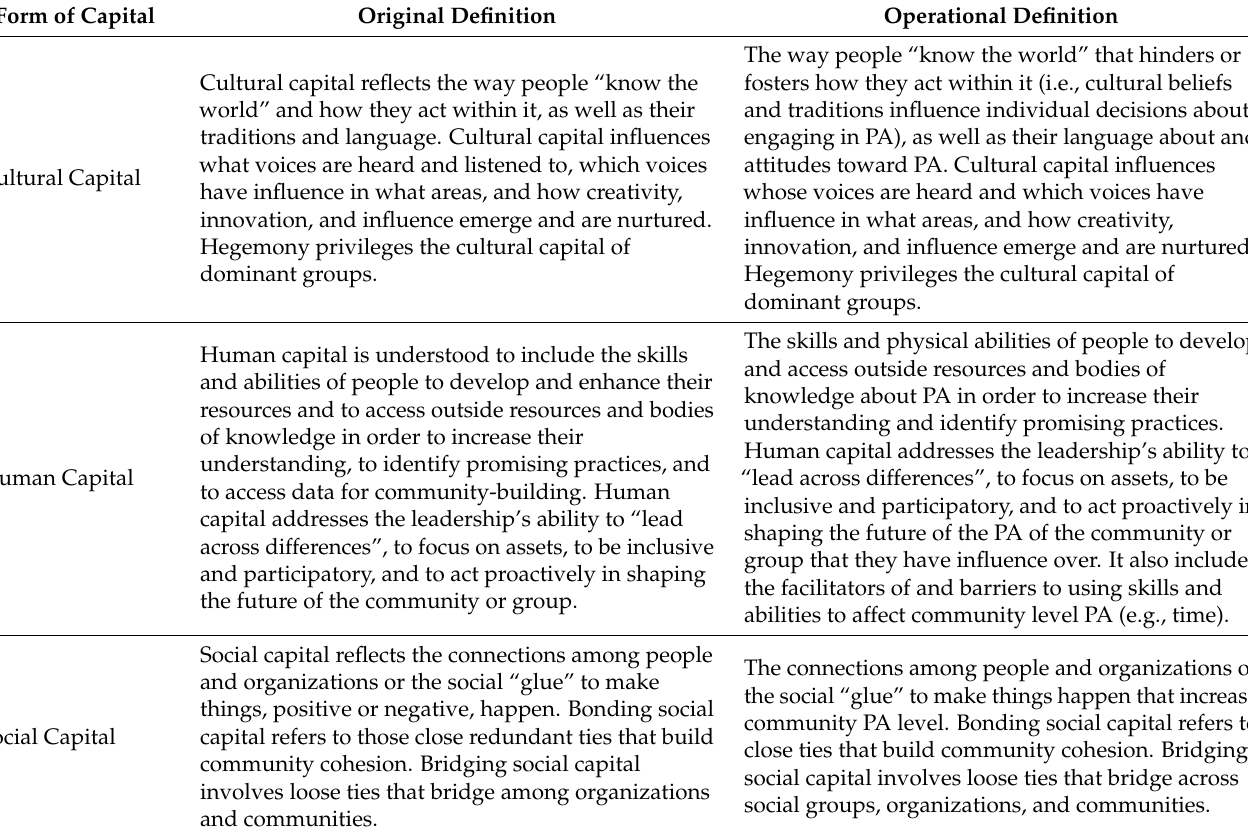
Table 3. Forms of Community Capital, original definitions [10] (pp. 20–21) and operational definitions utilized for the qualitative data